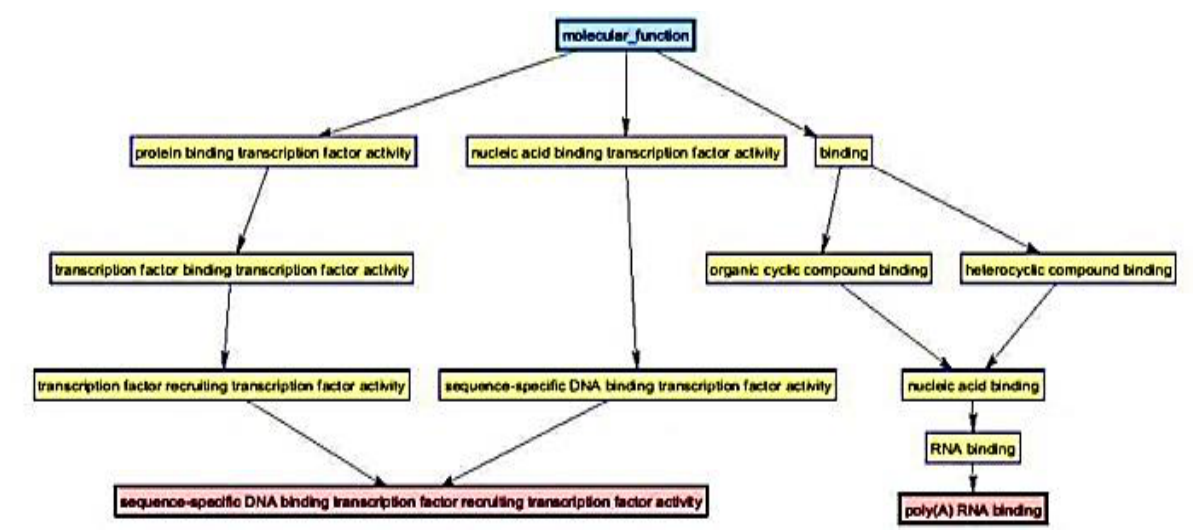
Figure 10. GO-Term